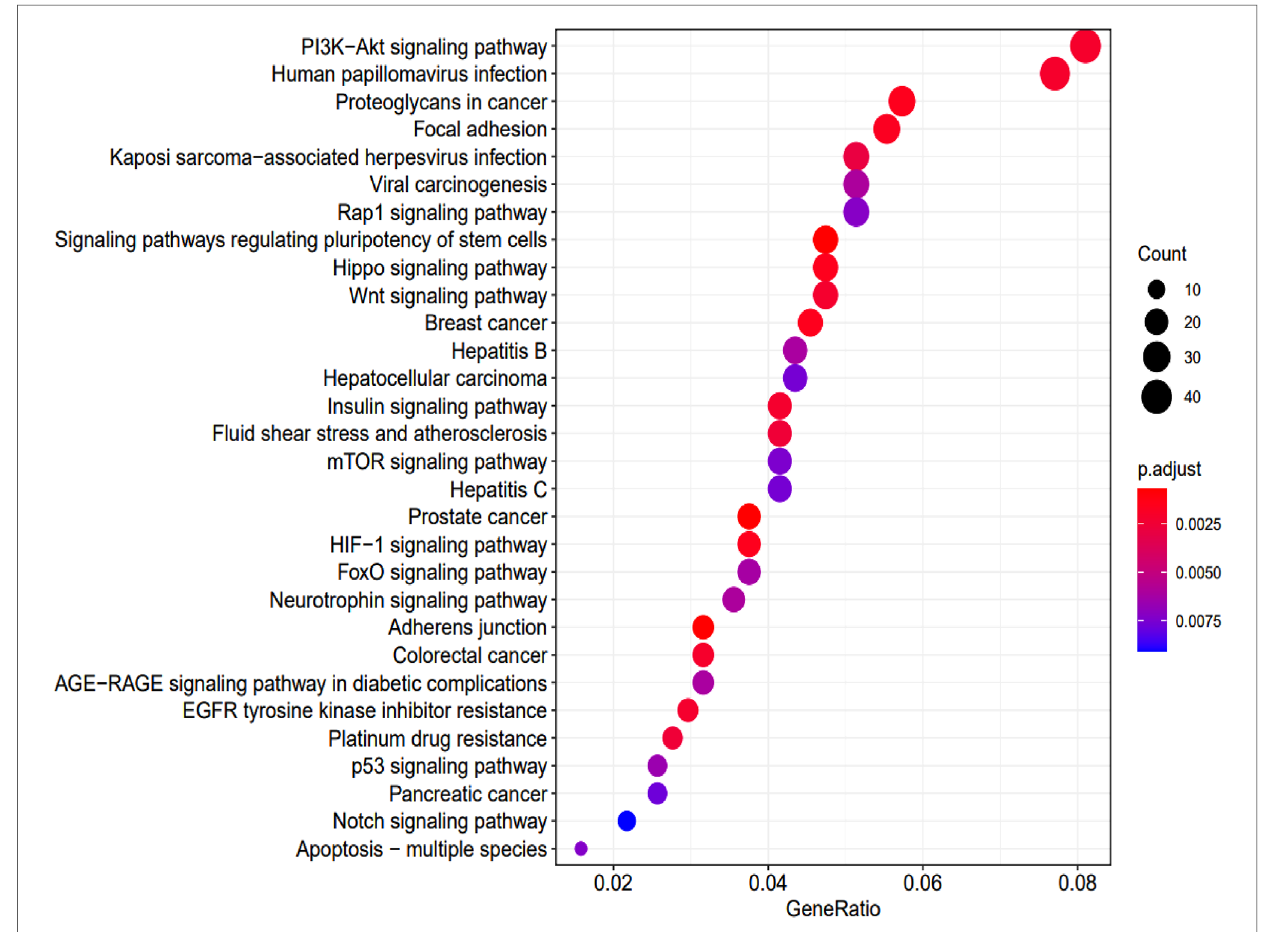
FIGURE 6 KEGG pathway analysis and the numbers of associated genes. The pathways and the associated genes were ranked based on the p -values. The sizes of the dots represent the gene counts of each row (KEGG